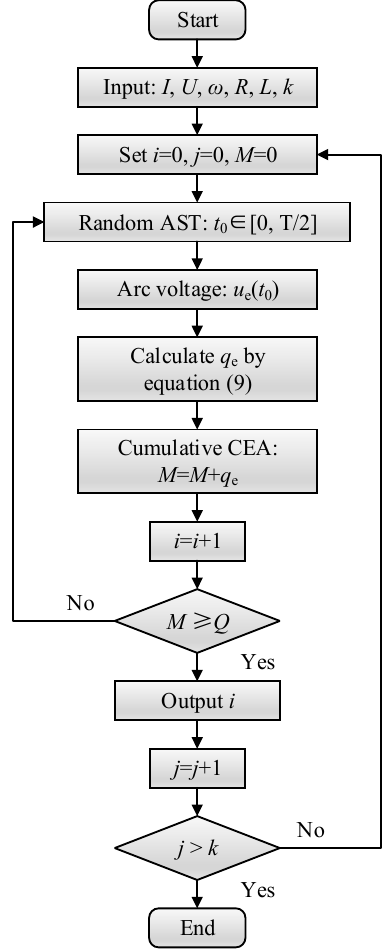
Figure 10. Simulation flow chart of electrical life.